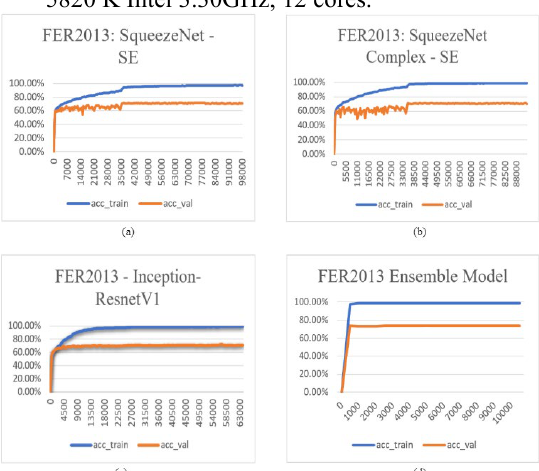
For the table 1: all three proposed models